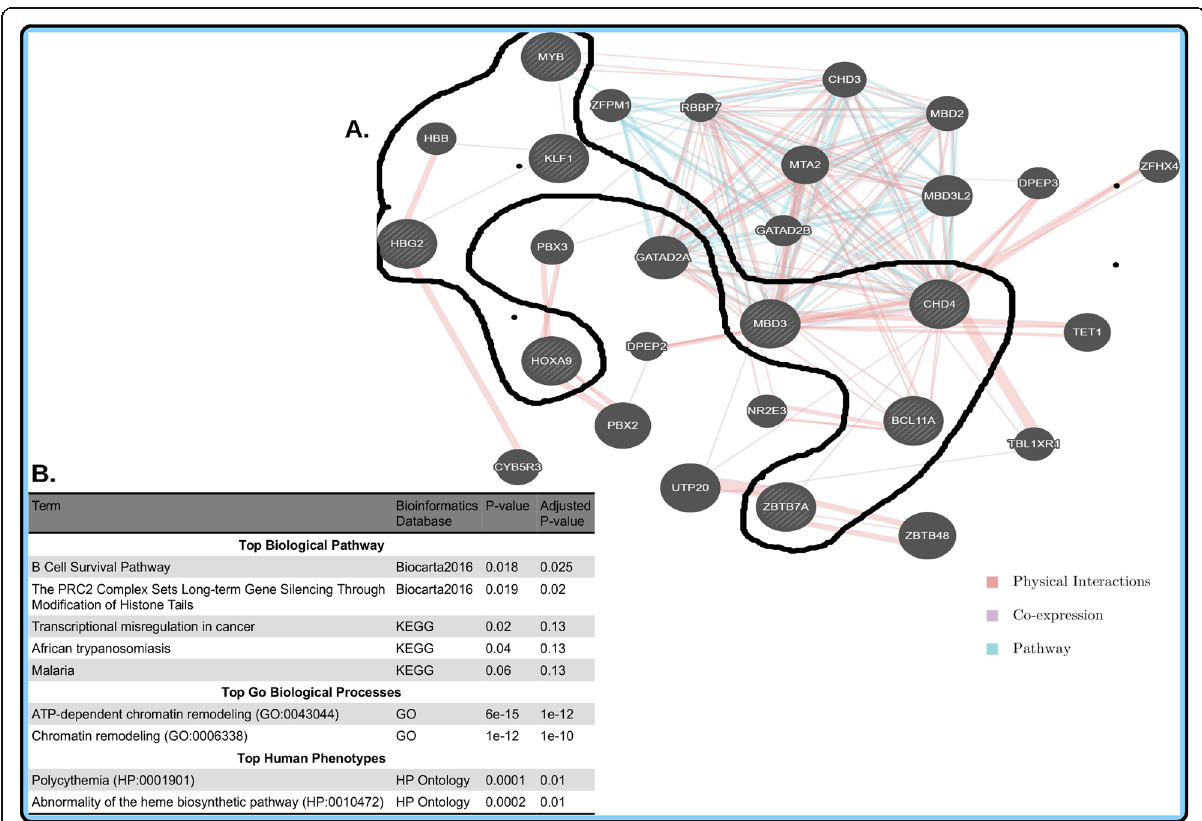
Fig. 4 Biological sub-network of the candidate mutant gene and identified modifier genes in 14 SCD patients from Tanzania. a sub-networks of our target sequencing variants include ZBTB7A, BCL11A, MYB, HBB, HOXA9, HBG2, CHD4, KLF1, MBD3. b description of the top most significant pathways, GO biological process, and Human Phenotypes associated with the identified